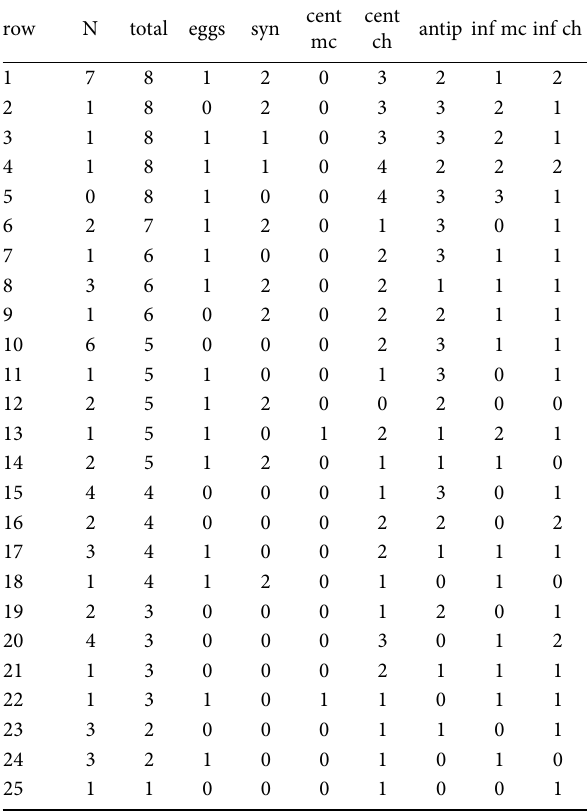
Table 3. Component counts in numerically abnormal embryo sacs in Z. chlorosolen a